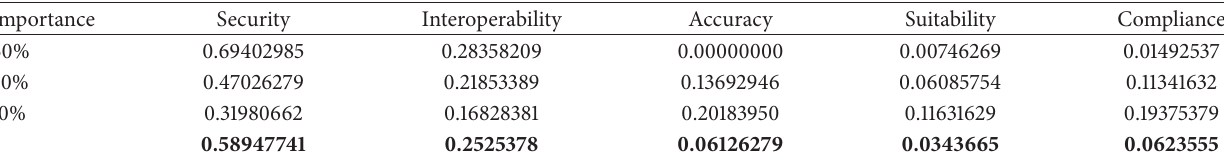
Table 5: Normalized value of the results of Search Types 1, 2, and 3, respectively, for Functionality.